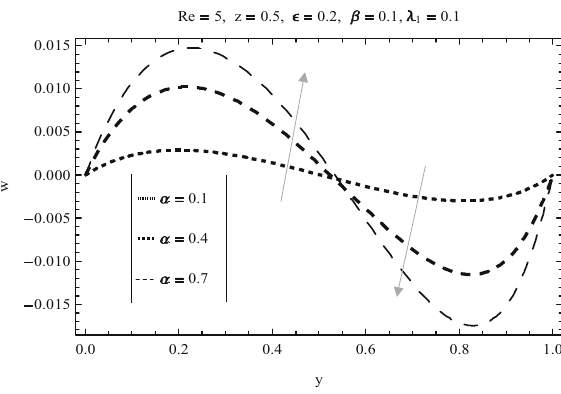
Fig. 10 Velocity component w along y for different values of α